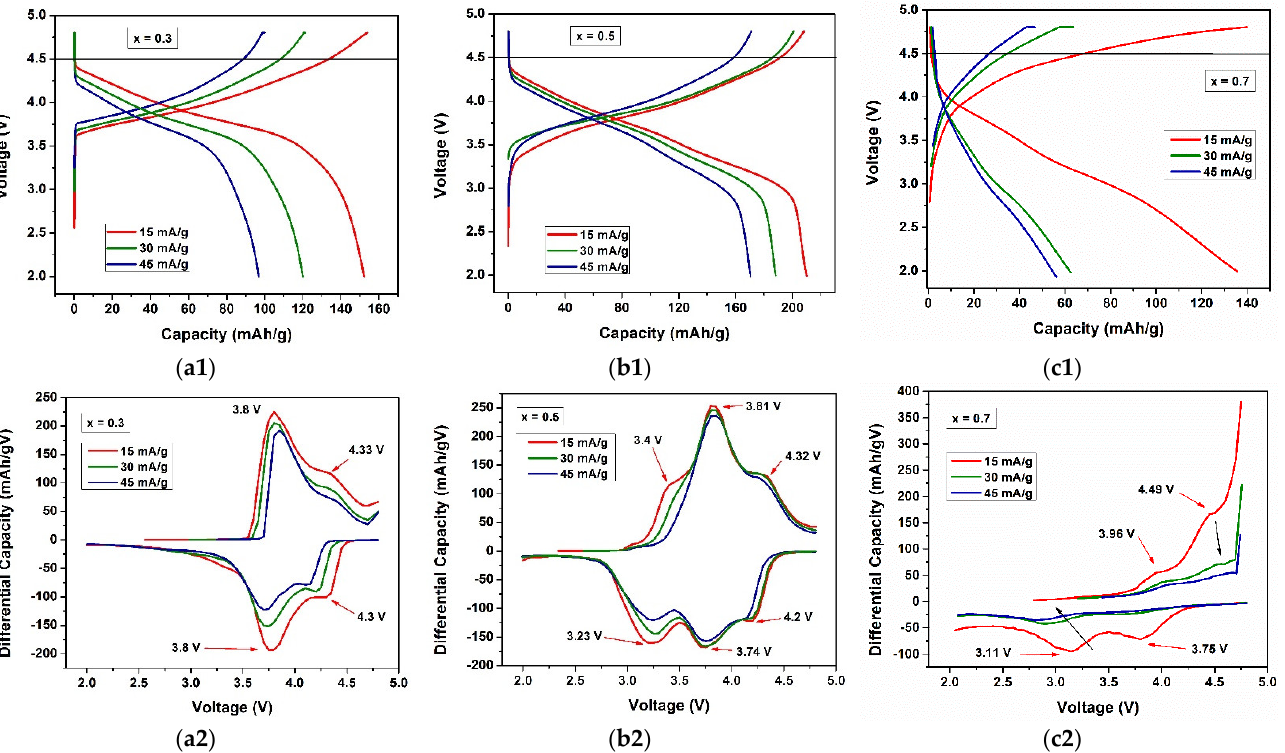
Figure 7. Charge–discharge profiles ( a1 – c1 ) and differential capacity plots ( a2 – c2 ) for 15, 30, and 45 mA/g current density for ( a ) 0.3Li 2 MnO 3 –0.7LiNi 0.5 Mn 0.5 O 2 , ( b ) 0.5Li 2 MnO 3 –0.5LiNi 0.5 Mn 0.5 O 2 , and ( c ) 0.7Li 2 MnO 3 –0.3LiNi 0.5 Mn 0.5 O 2 cathode materials.